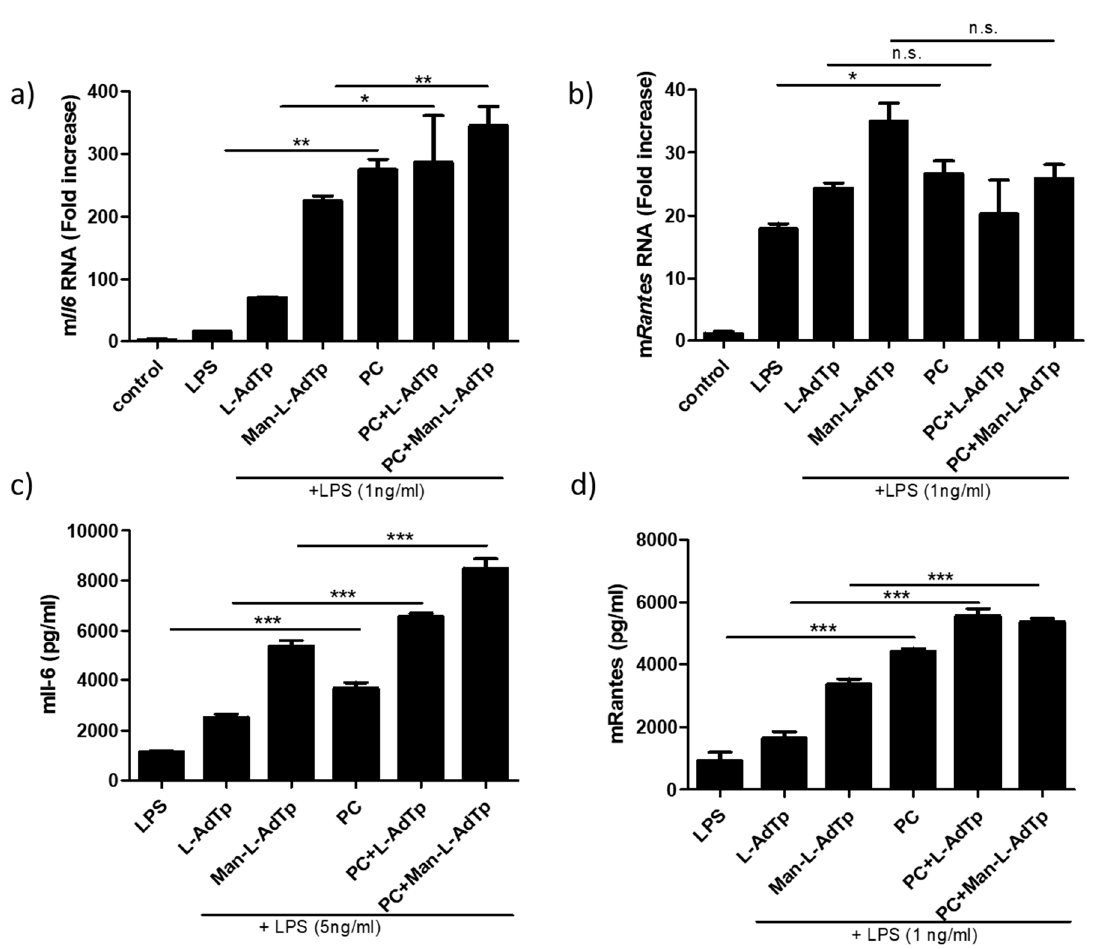
Figure 4. PGN derivatives incorporated into the lipid bilayer further augment immune responses as observed on the mRNA and protein level. ( a ) 1:5 PGN derivatives / PC mixtures were sonicated and DLS was measured. PGN derivatives (200 µ M PGN derivatives / 1mM PC mixtures) were preincubated for 1 h and then stimulated with LPS (1 ng / mL) for 4 h for qPCR and for 16h for the ELISA assay. RNA was isolated and qPCRs was performed; ( b ) for Il6 and ( c ) for Rantes . ELISA assay was performed for Il-6 ( c ) with 5 ng / mL LPS and for RANTES ( d ). Statistics: Student’s t -Test * p < 0.05, ** p < 0.01, *** p < 0.001. Statistics: Student’s t -Test * p < 0.05, ** p < 0.01, *** p < 0.001, n.s.—not significant. As control unstimulated cells were used. Representative experiments from 3 independent experiments are shown.